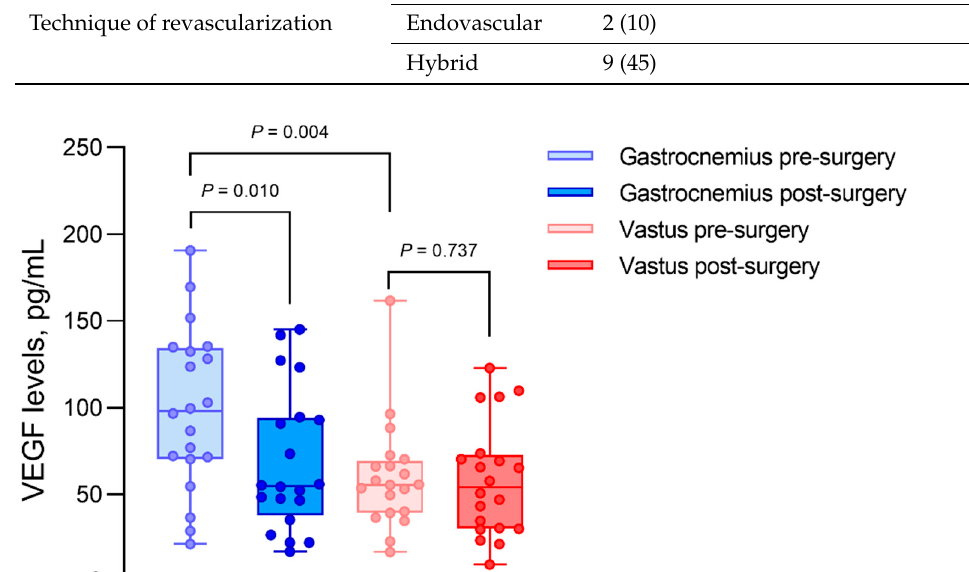
vs. post-op. 54.16 ± 40.66 pg/mL) (Table 2, Figure 1). The median difference in preoperative to postoperative values was 2.78 ± 32.18 pg/mL in vastus biopsies, compared to 34.29 ±